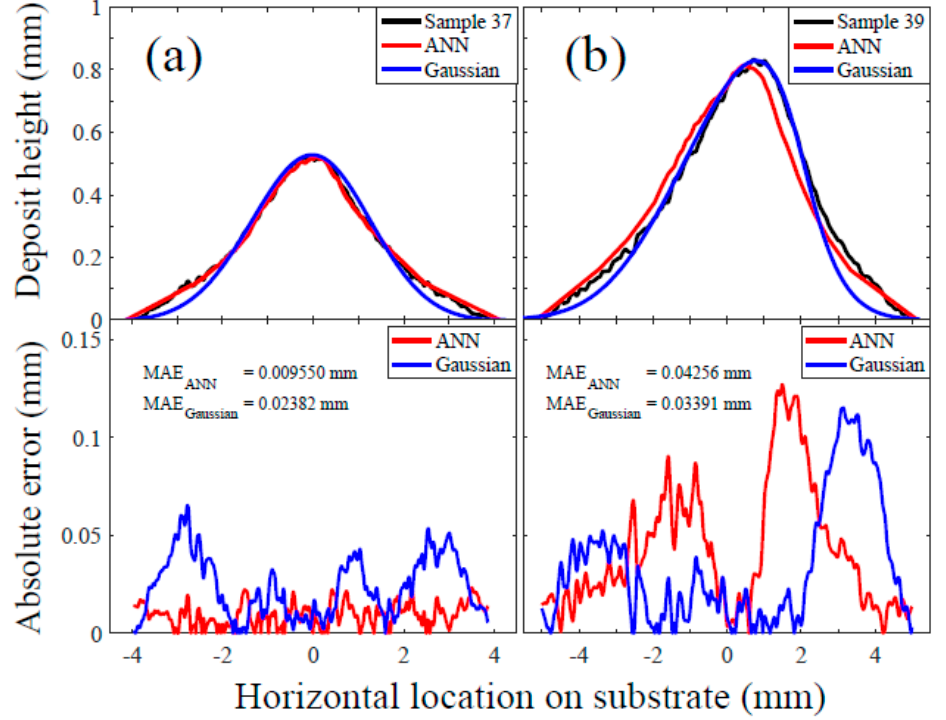
Figure 4. The experimental single-track profiles of the two selected samples are shown as illustrative examples along with the corresponding ANN (red) and Gaussian (blue) models: ( a ) Sample 37 (spray angle: 86°, traverse speed: 75 mm/s, standoff distance: 45 mm) and ( b ) Sample 39 (spray angle: 48°, traverse speed: 34 mm/s, standoff distance: 41 mm).